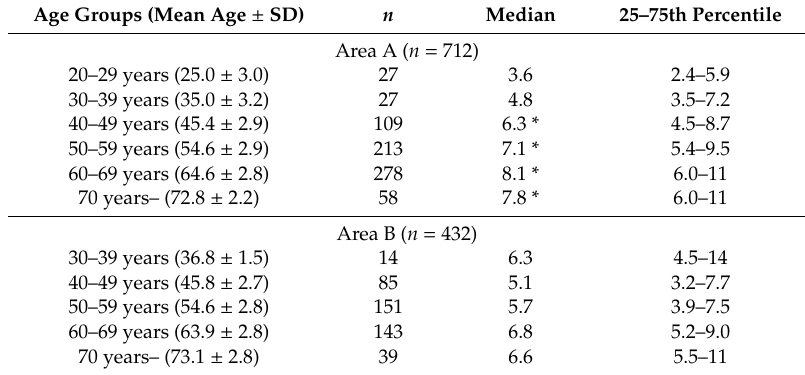
Table 14. Age-classified weekly cadmium intake per body weight (µg/kg BW/week) in female farmers in areas A and B.